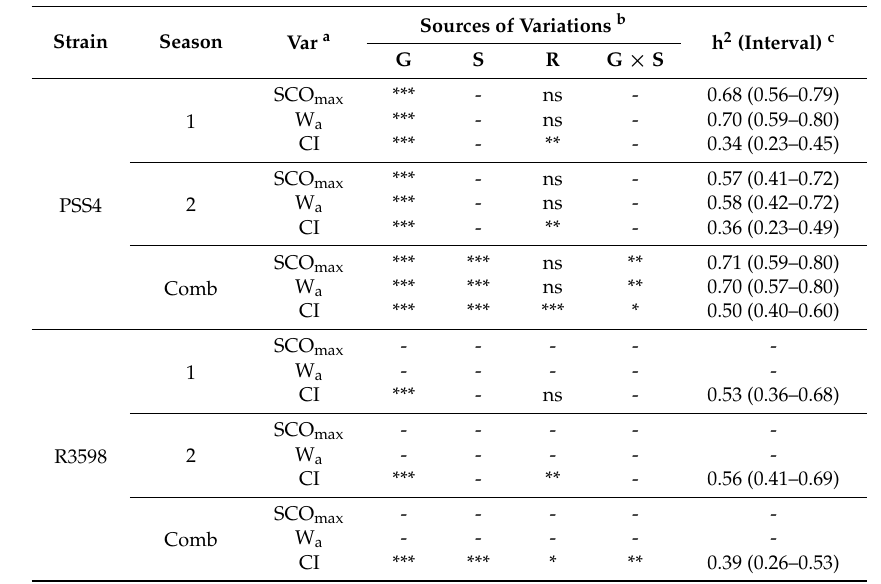
Table 2. Sources of phenotypic variation (Anova analysis) and estimates of heritabilities (broad sense) for SCO max , W a , and CI for the EG203 × MM738 DH